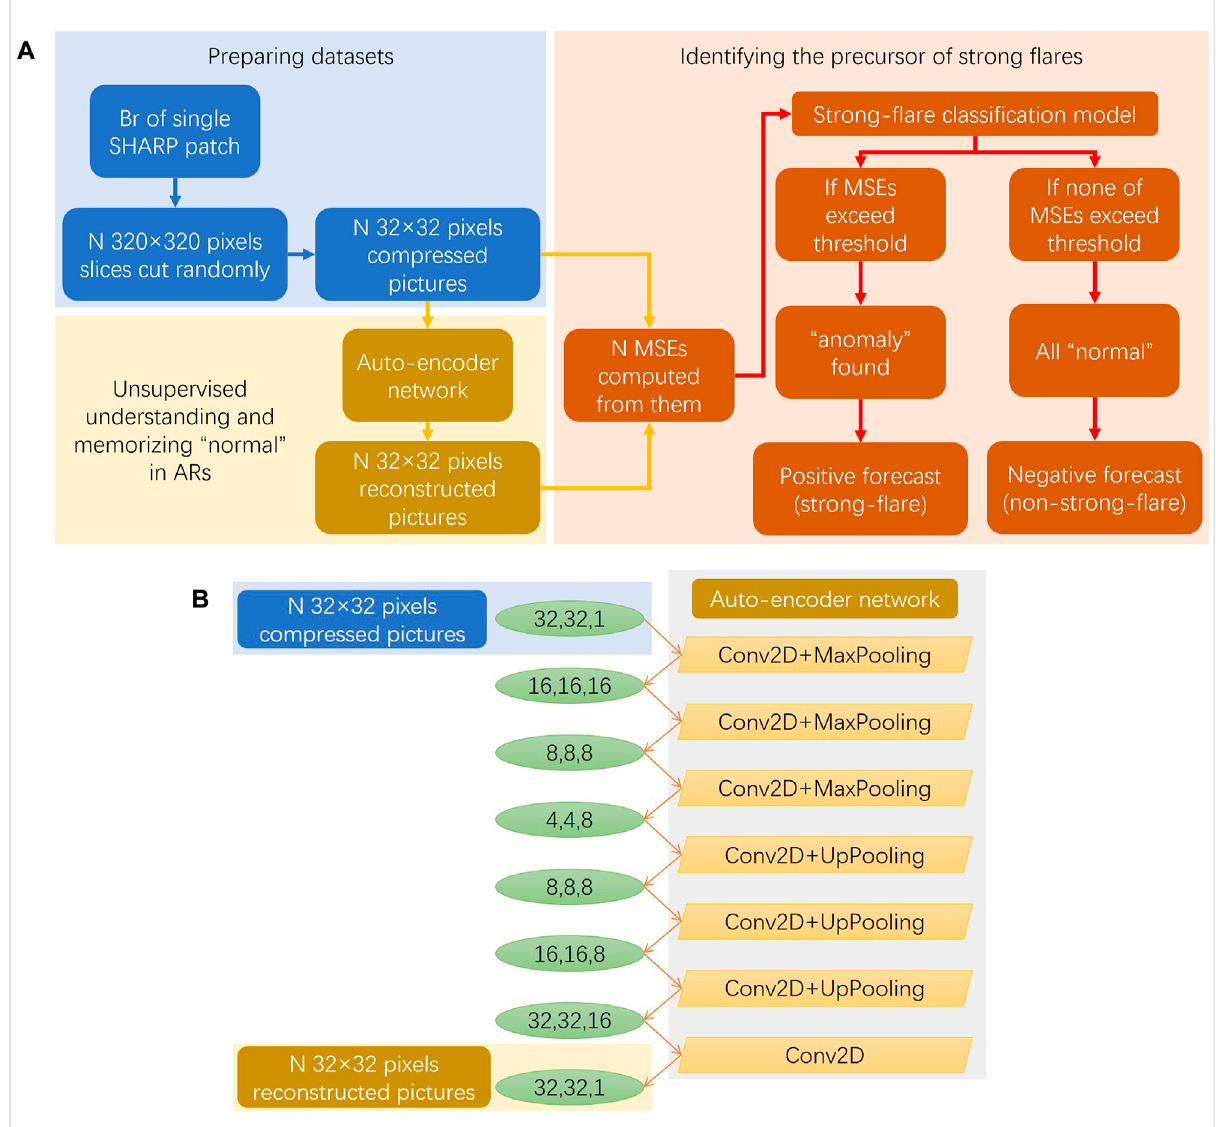
FIGURE 1 Flow chart for data preparation and model development. (A) is the fl ow chart. (B) illustrates the structure of the auto-encoder